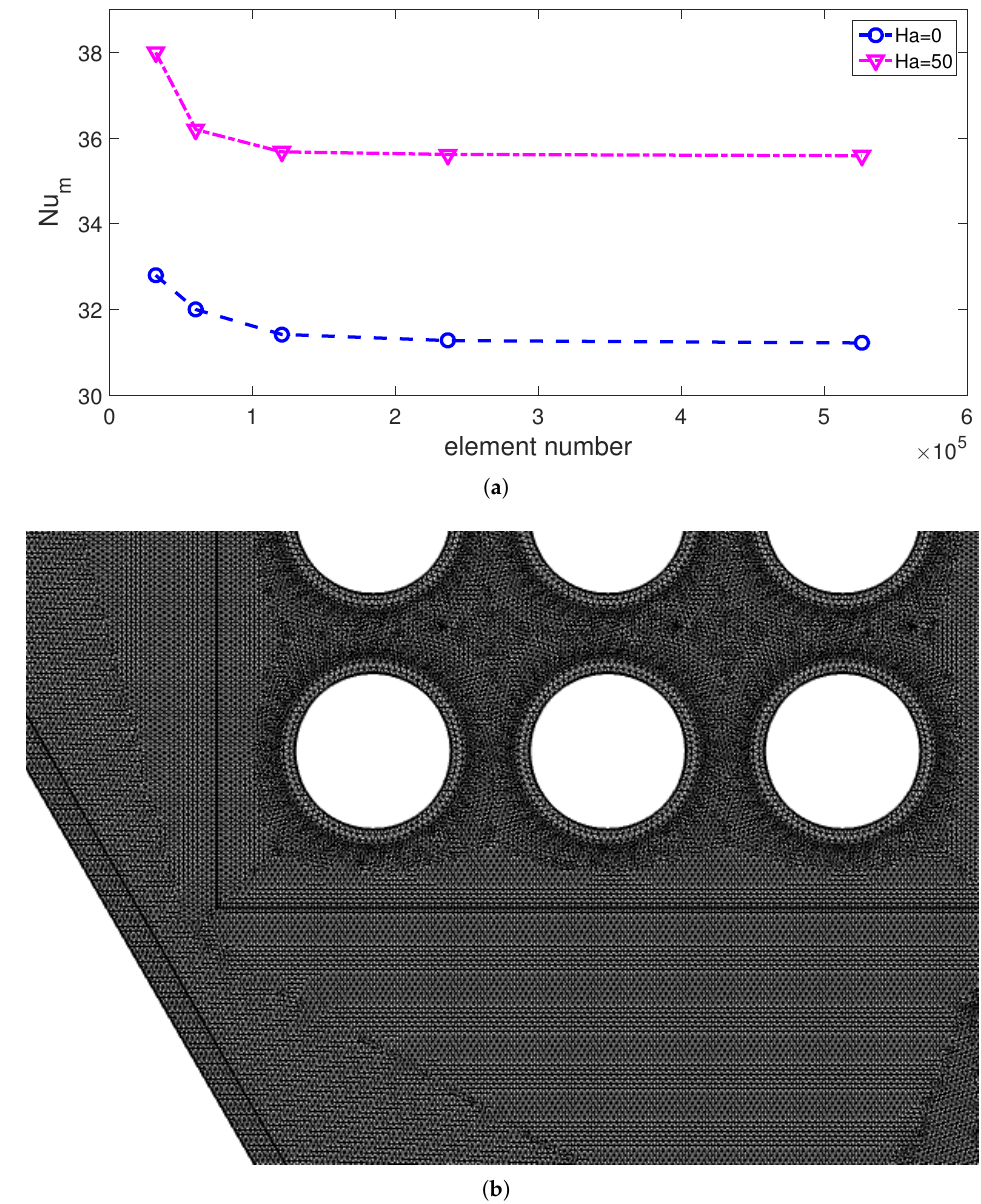
Figure 3. Mesh independence test results for average Nu versus element number at two